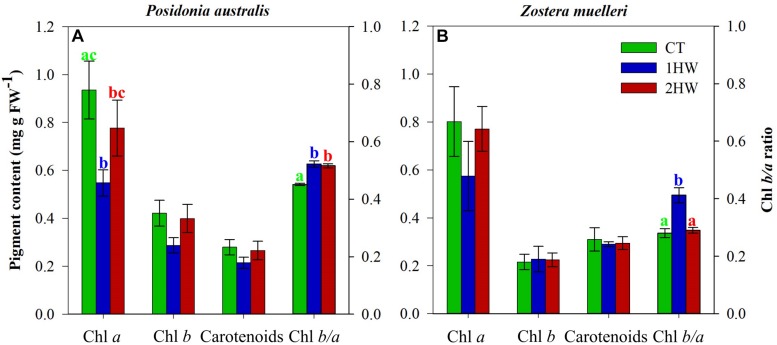
Pigment relations at the end of the second heatwave (T7): Chlorophyll a (Chl a), Chlorophyll b (Chl b), Carotenoids and the Chlorophyll b/a molar ratio (Chl b/a) in P. australis
(A) and Z. muelleri (B). CT = control plants; 1HW = non-pre-heated plants; 2HW = pre-heated plants. Different letters (a–c; green letters correspond with CT, blue letters correspond with 1HW and red letters correspond with 2HW treatment) indicate significant differences (p < 0.05) among treatments as derived from Tukey HSD post hoc analyses. Error bars present ±SE, n = 5.